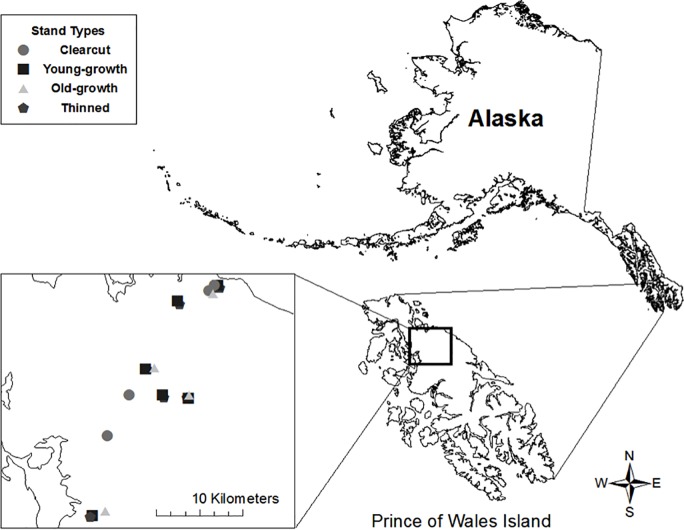
Study area and small mammal trapping grid locations on Prince of Wales Island, Alaska, USA, 2010–2012.Trapping grids were located in seven thinned, six un-thinned young-growth, four old-growth and four clearcut stands.